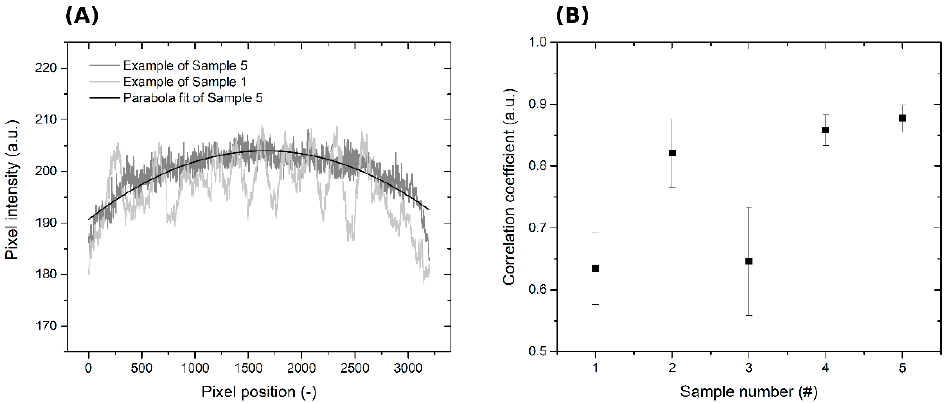
Figure 5. ( A ) Examples of waveforms of pixel intensities along a line in the CD taken from images of samples 1 and 5. A parabola fit of the sample 5 waveform. ( B ) Correlation coefficients of all the five samples.